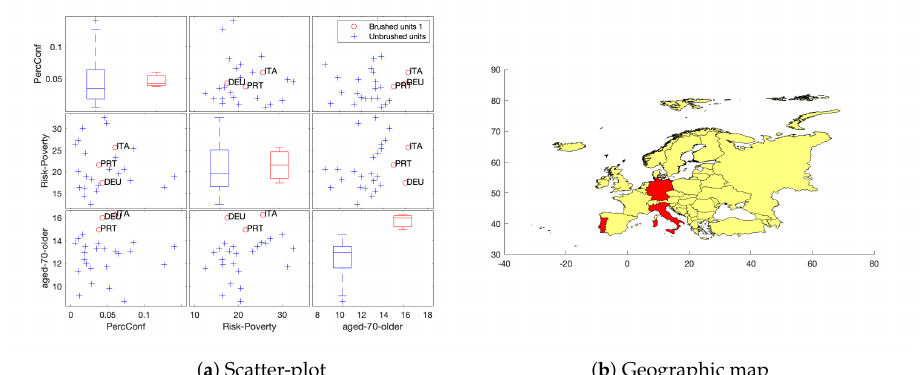
Figure 5. Exploratory step: Data brushing on multiple scatter-plot and box-plots to highlight countries on a map: points highlighted on scatter-plots are colored in red on the map. Wave 2.